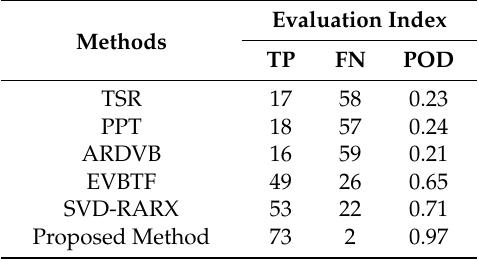
Table 4. Results of different detection methods evaluated in the whole